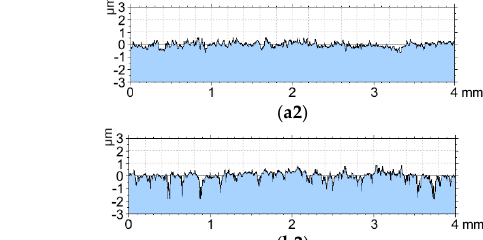
Figure 13. Roughness profiles: ( a ) aluminum alloy EN AW-5251, ( b ) Al 2 O 3 layer.